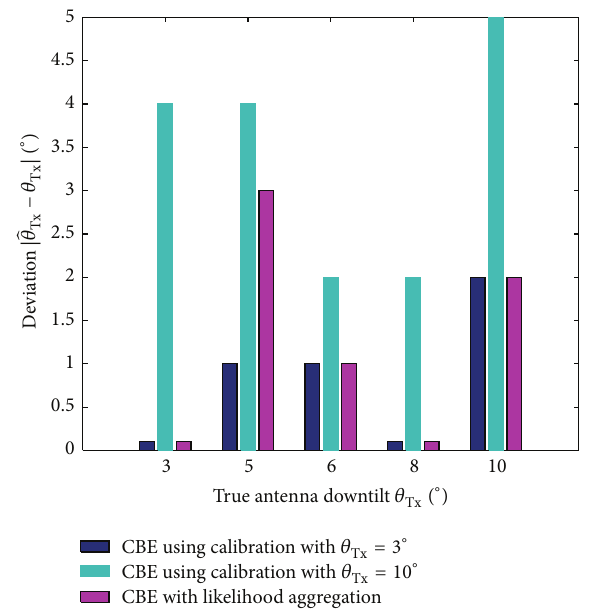
|̂𝜃 − 𝜃 | between the true antenna downtilt Tx Tx